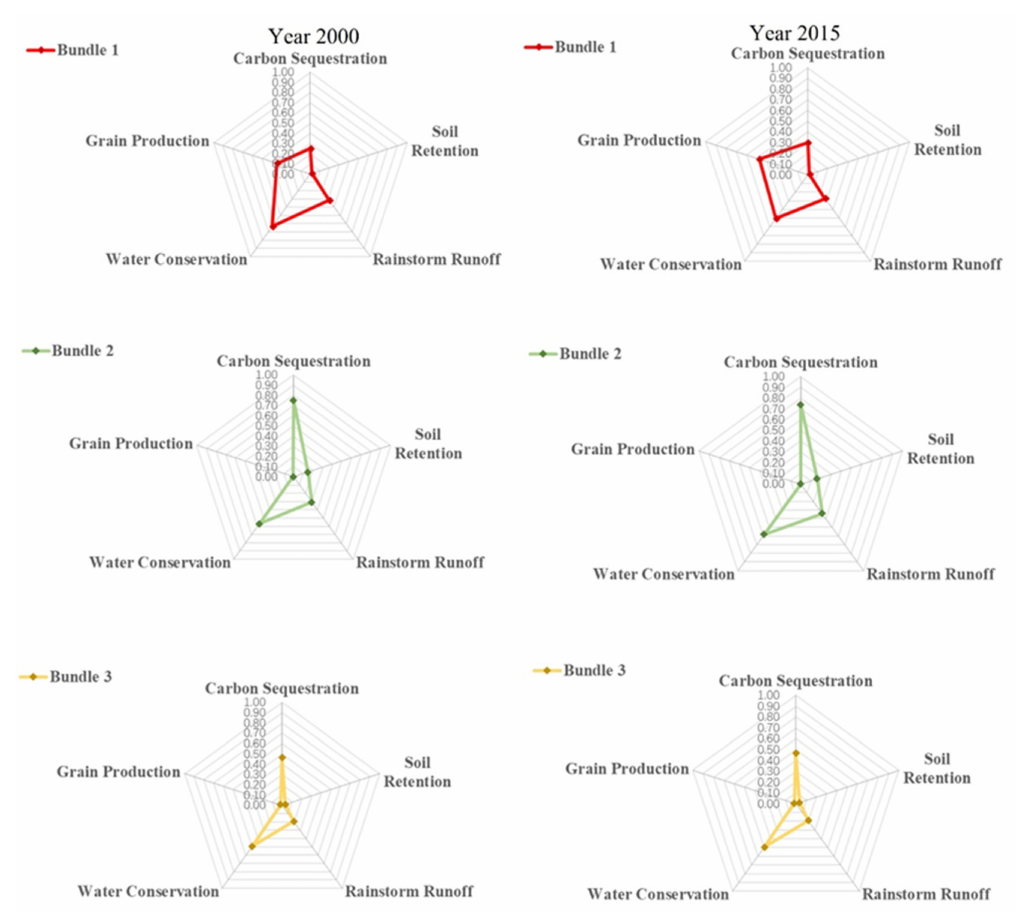
Figure 4. Spider web map of ecosystem service bundle in the Guangdong-Hongkong-Macao Greater Bay Area. Note: Ecosystem Service Bundle 1 (ESB 1)—red; Ecosystem Service Bundle 2 (ESB 2)—green; Ecosystem Service Bundle 3 ESB 3)—yellow.